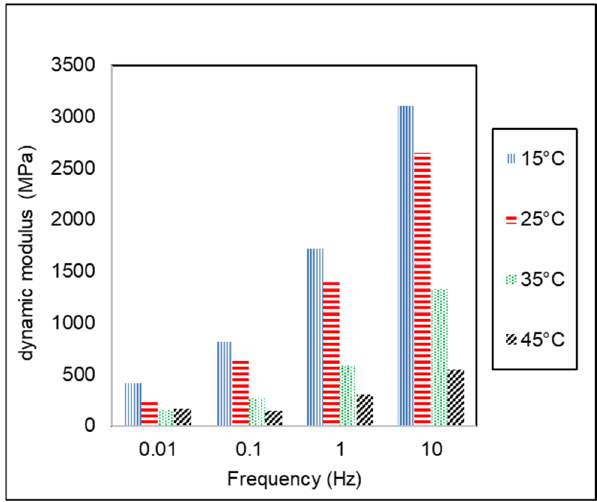
Figure 7. Variation of Dynamic Modulus of HRS-WC mixture with temperature and frequency.